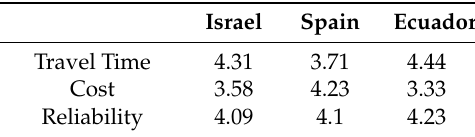
Table 6. Importance of Reliability vs. Cost vs. Travel time on a scale 1–5 (1 = less important; 5 = more